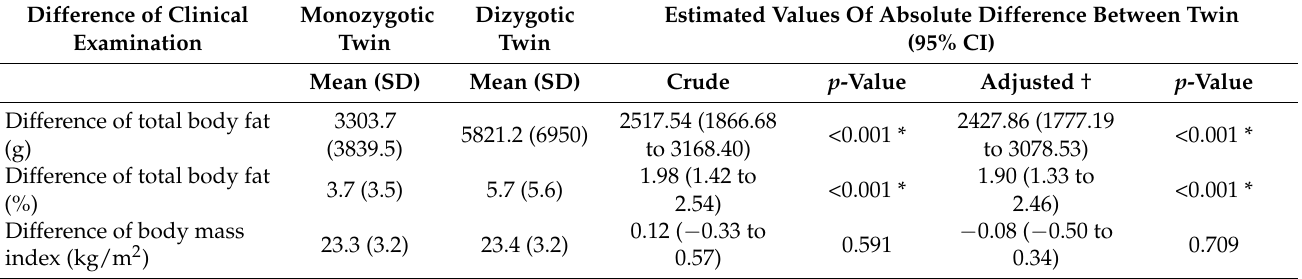
Table 3. Estimated values of total body fat and body mass